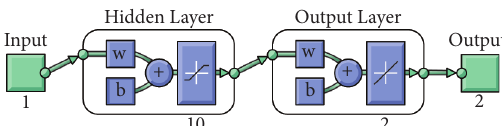
Figure 2: Neural network model